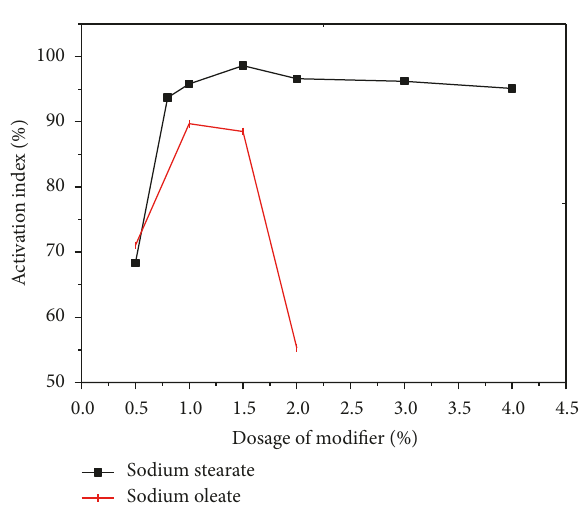
Figure 4: Activation index of modified TiO 2 with the amount of